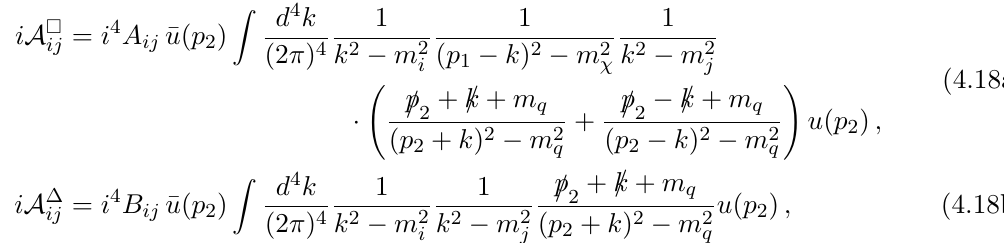
transfer limit allows to express the diagrams